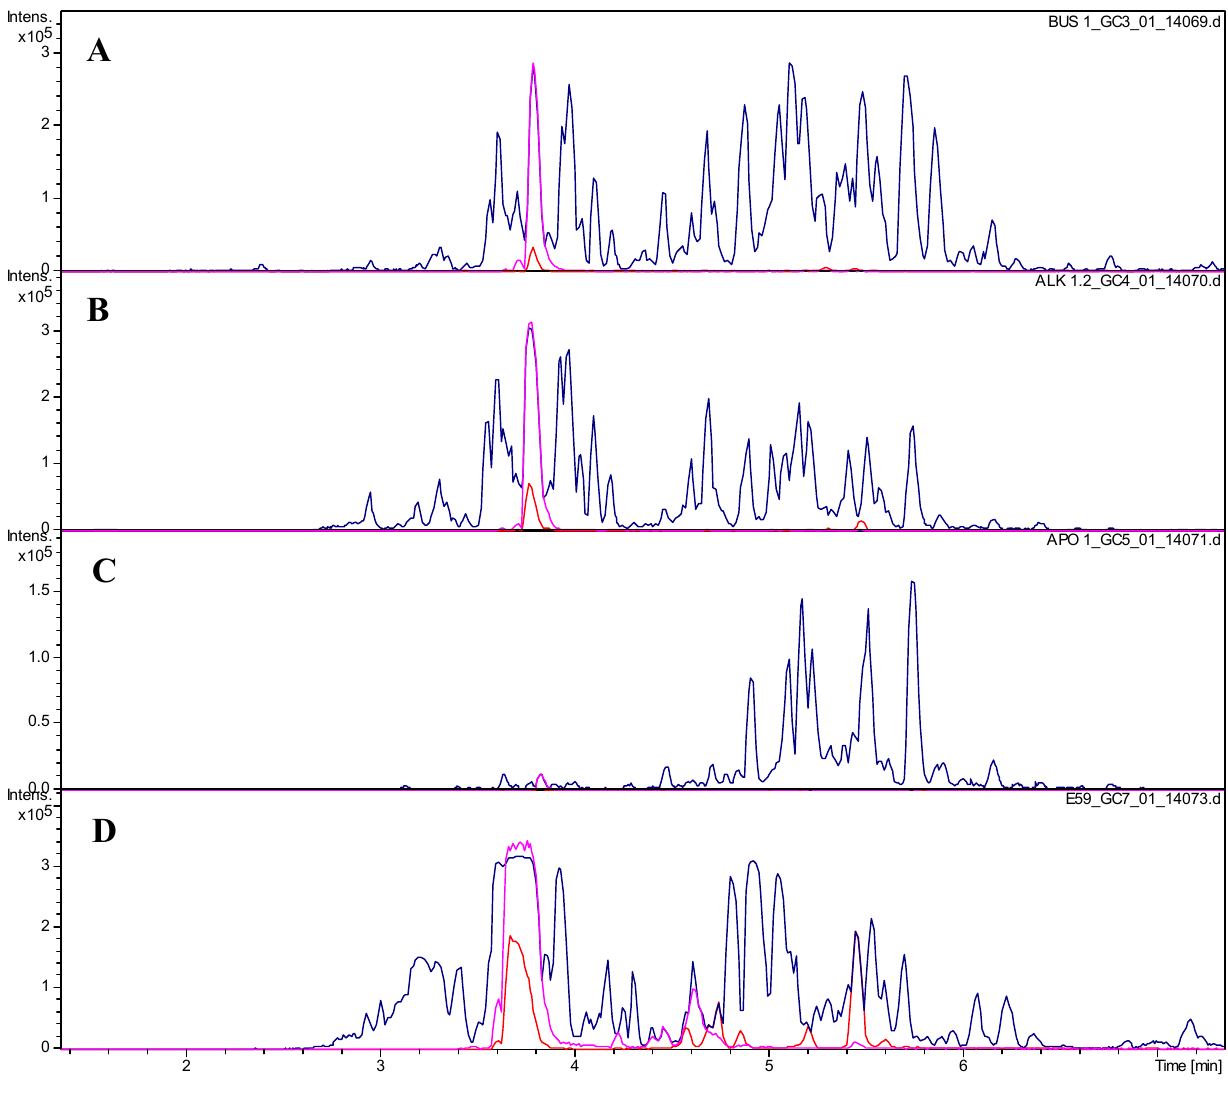
Figure 2. UHPLC/+ESI-QTOF-MS chromatograms of ( A ) the crude extract, ( B ) the alkaloid fraction ALK, ( C ) the non-polar neutral fraction APO and ( D ) of subfraction E 59. Blue: Base peak chromatogram of m/z 100–1000, Red: Extracted ion chromatogram